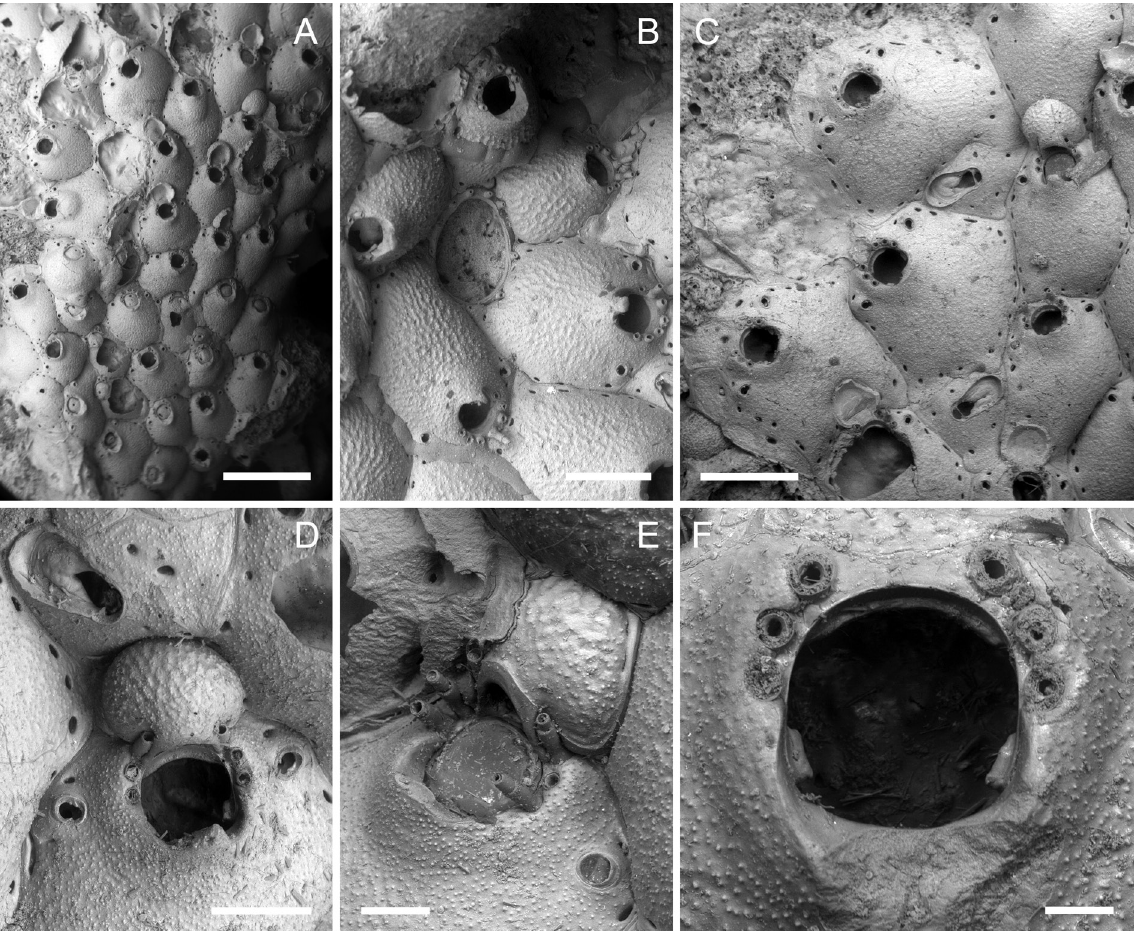
Fig. 11. Bathycyclopora vibraculata (Calvet, 1931) gen. et comb. nov., Azores. A . Overview of lectotype (MOM INV-22480a). B . Periancestrular region (MOM INV-22480a). C . Zooids at the colony growth margin and interzooidal avicularia (paralectotype, MOM INV-22480b). D . An ovicellate zooid and an interzooidal avcularium (paralectotype, MOM INV-22480b). E . Lateral view of an ooecium showing the thin marginal band of ectooecium (MOM INV-22480a). F . Close-up of orifice (MOM INV-22480a). Scale bars: A = 1 mm; B = 300 µm; C = 500 µm; D = 200 µm; E = 100 µm; F = 50